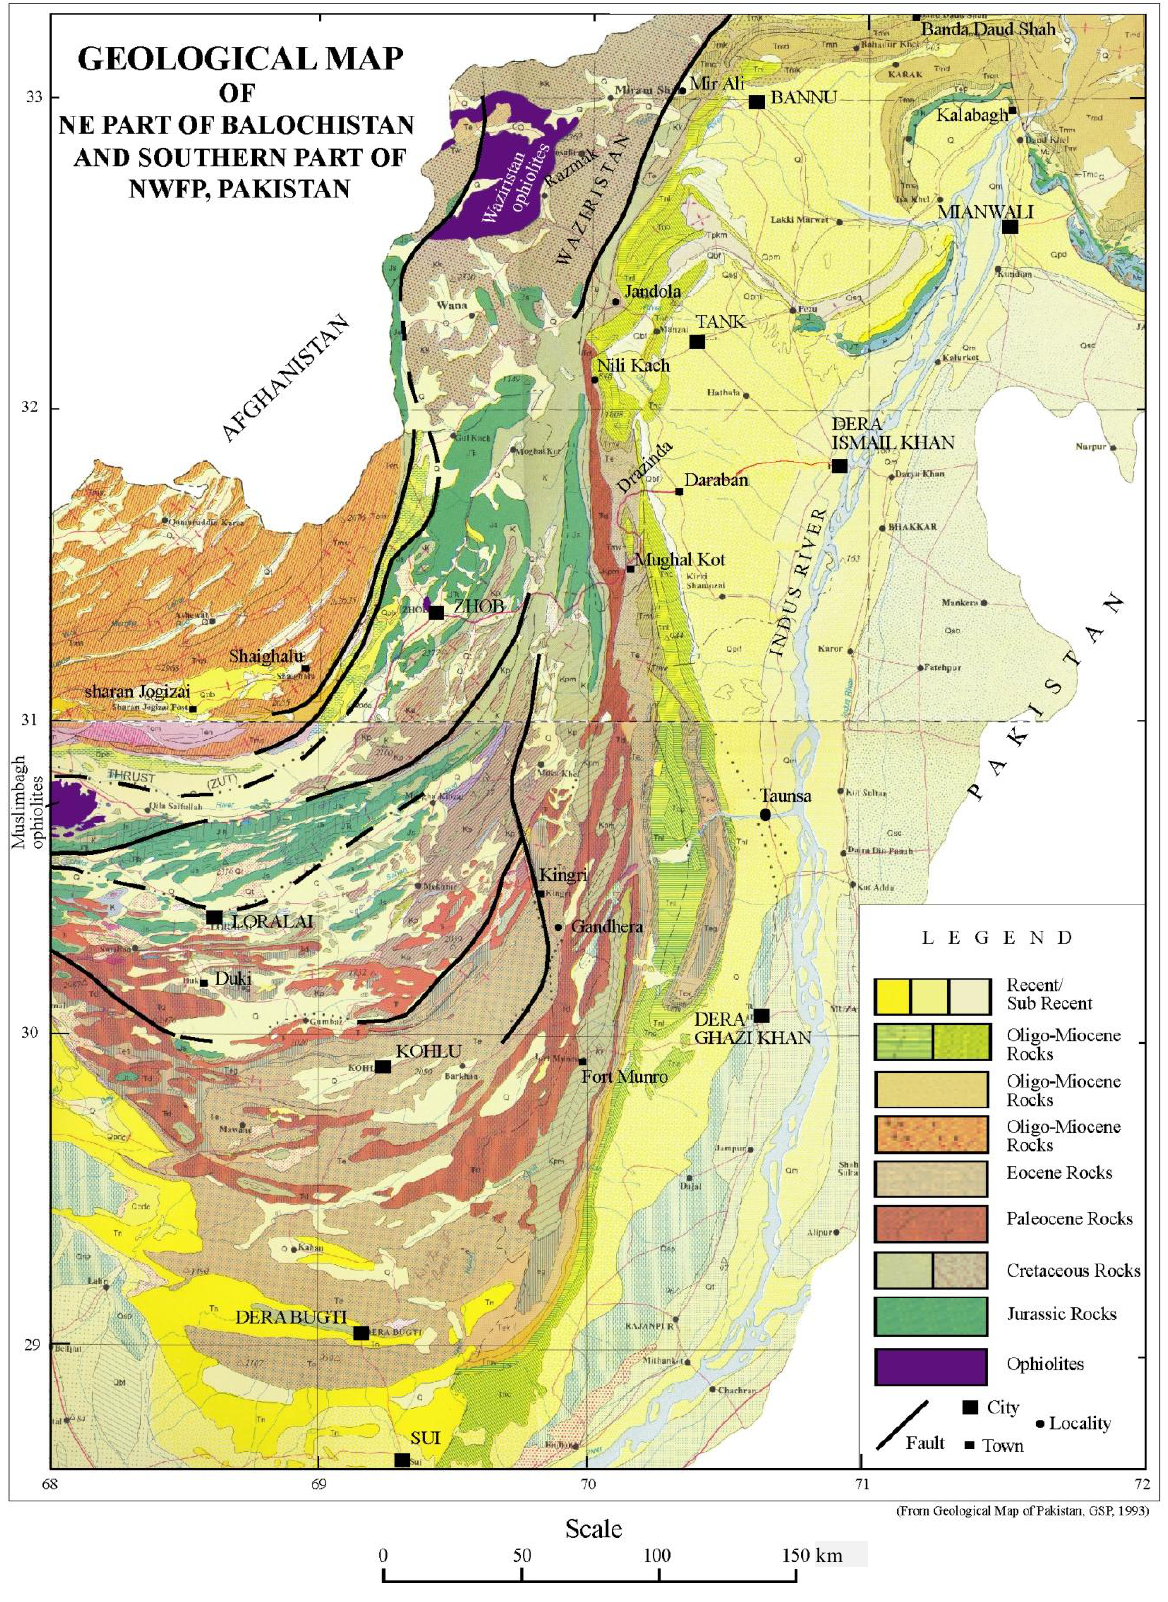
Figure A3. General geological map of the Muslimbagh, Loralai and Zhob areas of northeastern Balochistan and Mughal Kot, Dera Ismail Khan, Waziristan areas of the southwestern part of Khyber Pakhtunkhwa of Pakistan (adapted from Geological Map of Pakistan